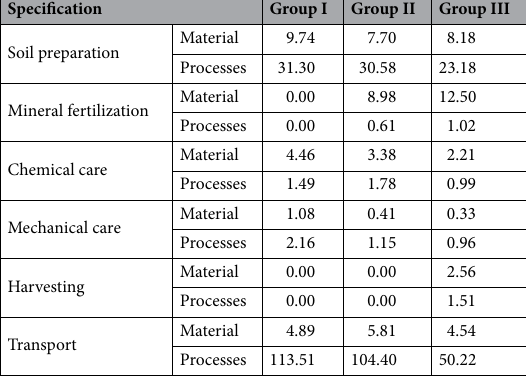
Table 14. The structure of the total environmental impact as per plantation area (Pt·ha −1 ).